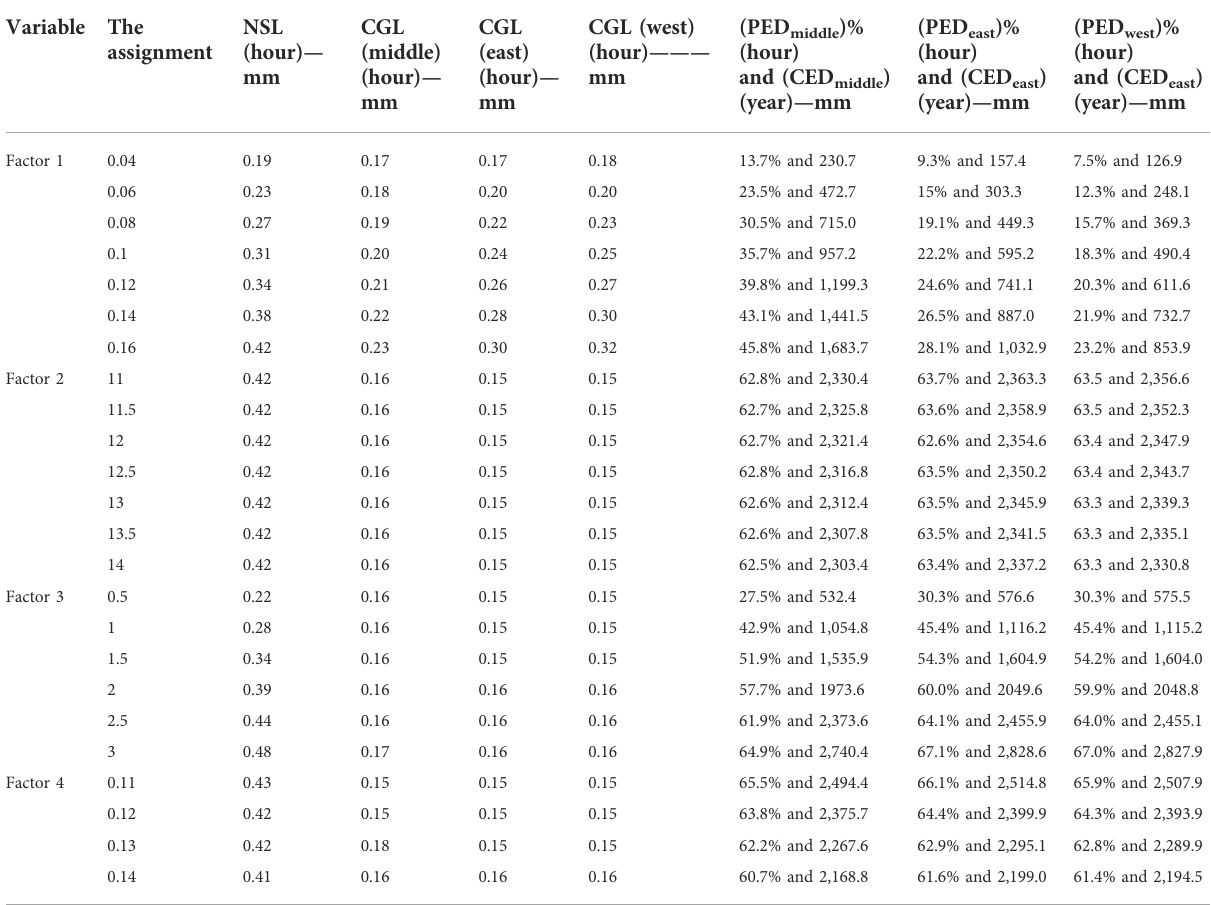
TABLE 3 Per hour PED and CED of evapotranspiration under the different underlying surfaces based on the assignment calculation of various impacting factors between CGL and NSL. Variable The